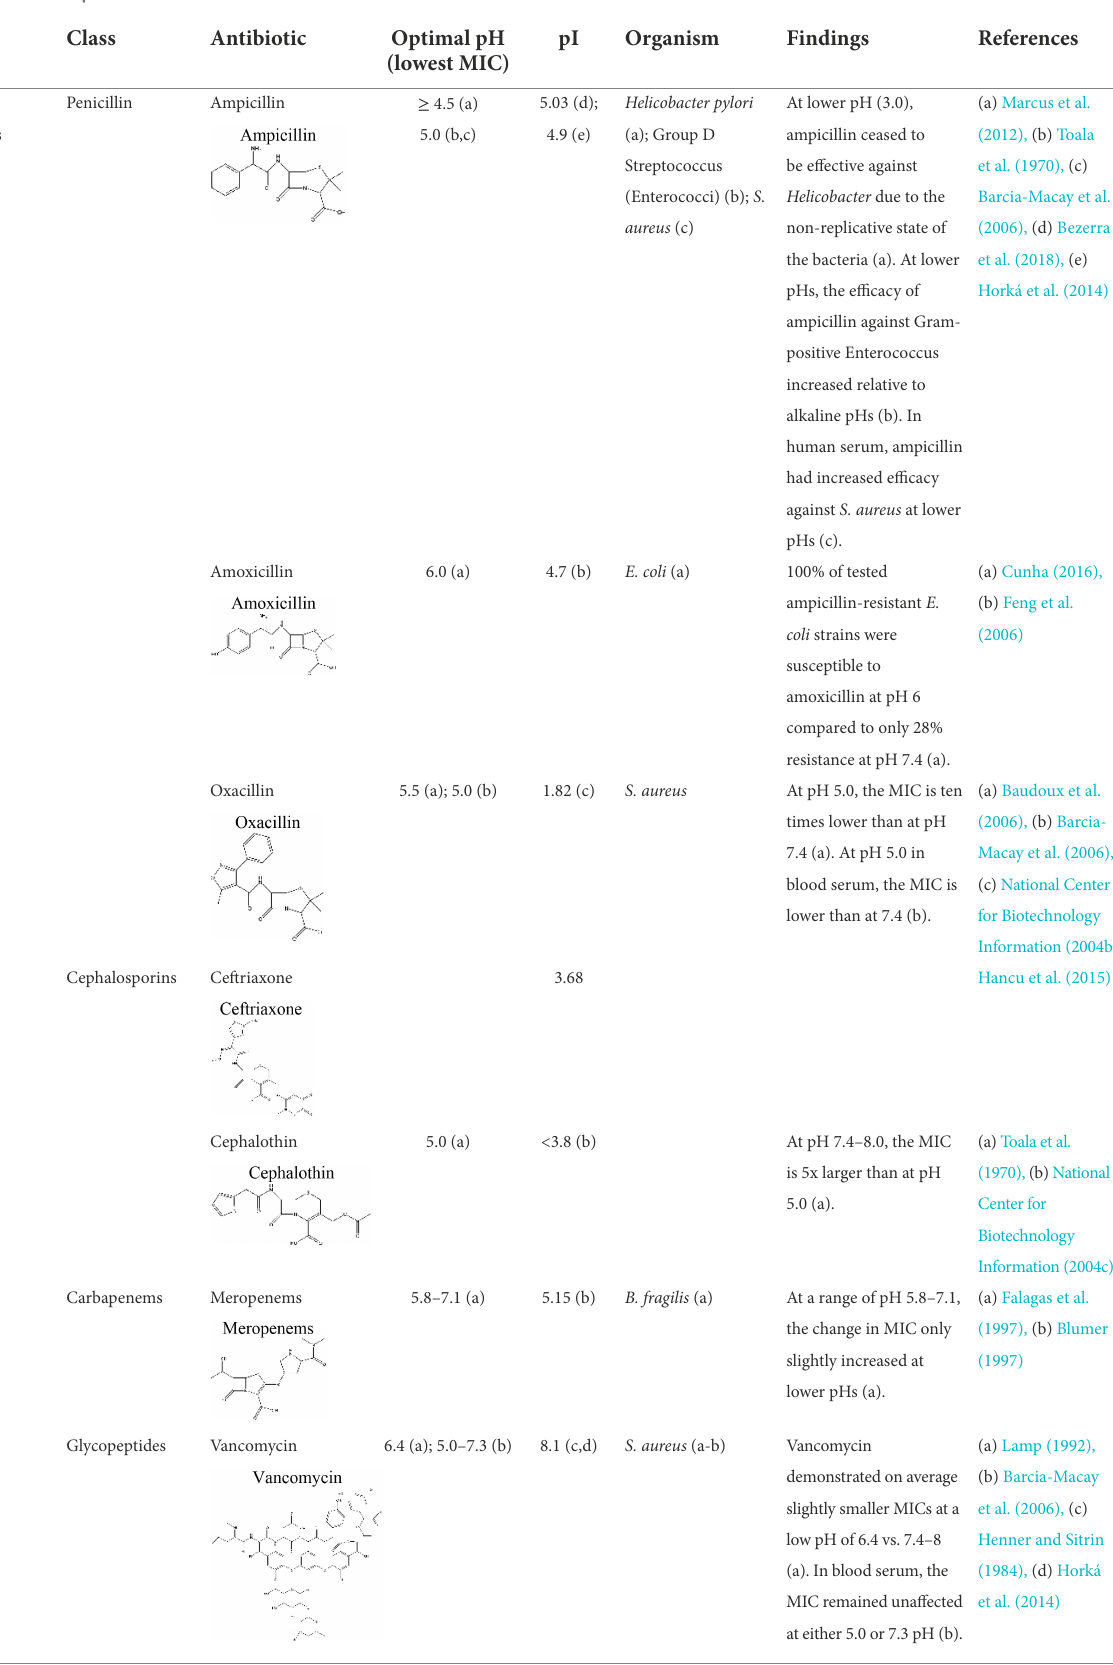
TABLE 3b Effects of pH on MIC of various classes of